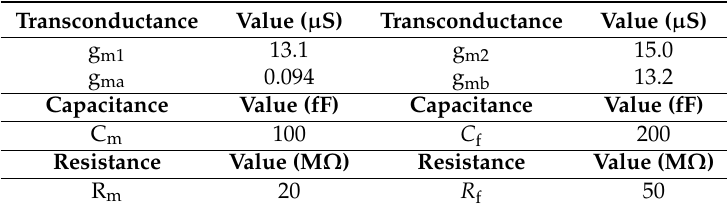
Table 3. Design parameters of the proposed work.